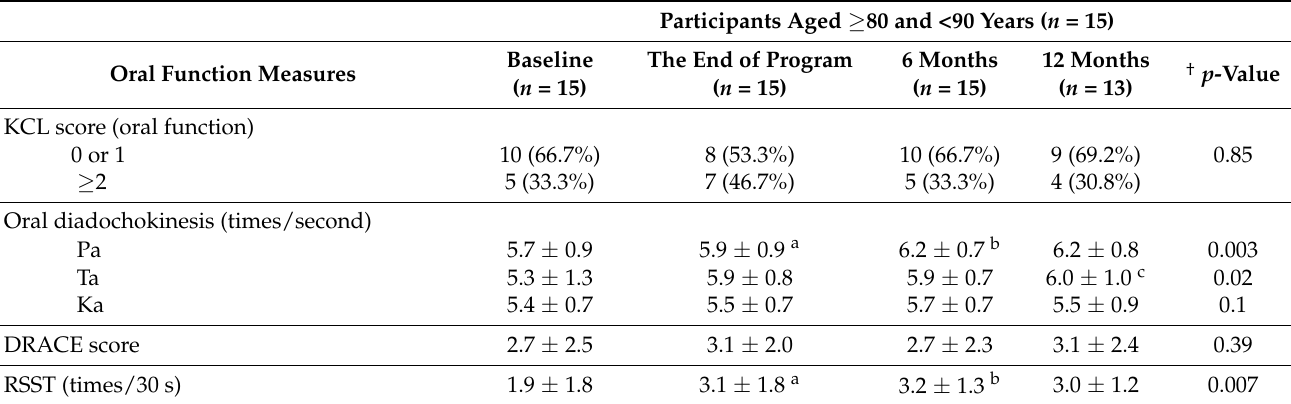
Table 5. Changes in oral function in participants aged ≥ 80 and <90